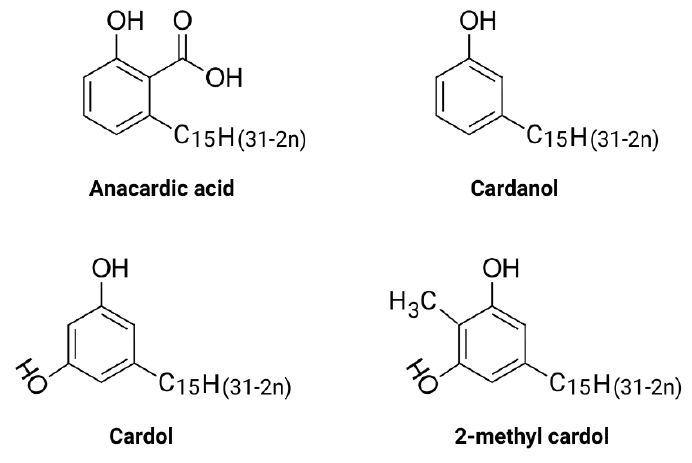
Figure 1. Chemical structure of CNSL with its components.